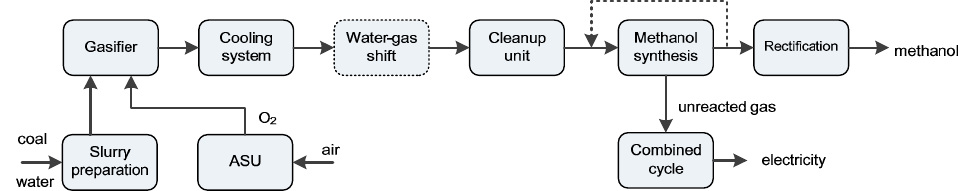
Figure 1. A series polygeneration system based on coal gasification.